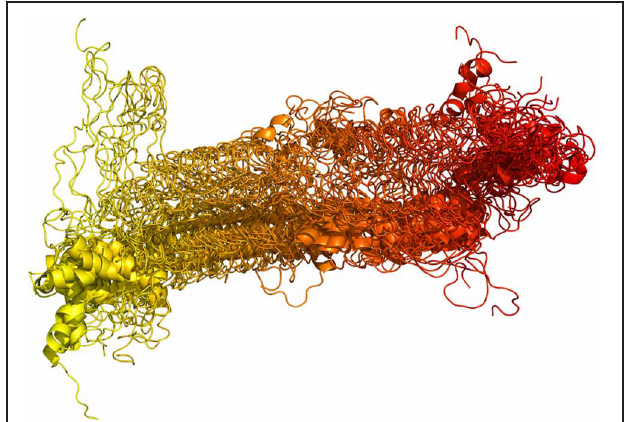
FIGURE 2 | Structural displacement of the Sic1 KID domain in the MD macro-trajectory. The equilibrated parts of each replicate were concatenated in a single macro-trajectory of more than 0.5 μ s, shown here. Snapshots are collected every 2ns, overlaid and represented by a color gradient, from yellow (the starting structure of replicate 1) to red (the last frame of replicate